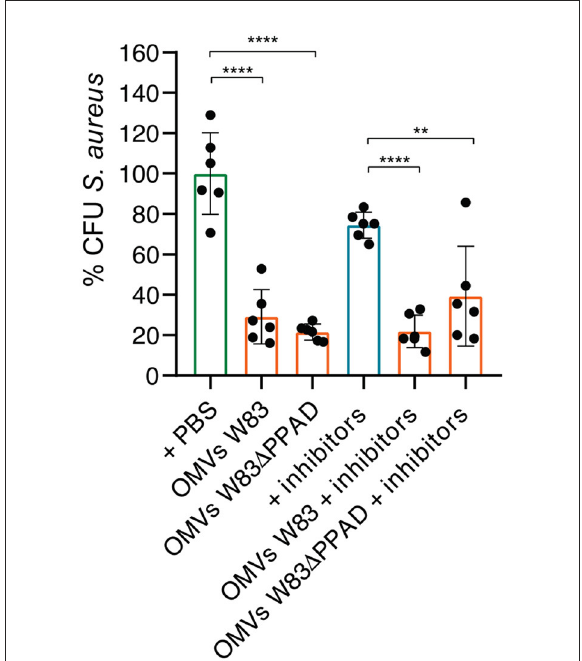
FIGURE1 Exposure to P. gingivalis OMVs decreases S. aureus CFU counts. S. aureus HG001 was incubated for 90min with OMVs of